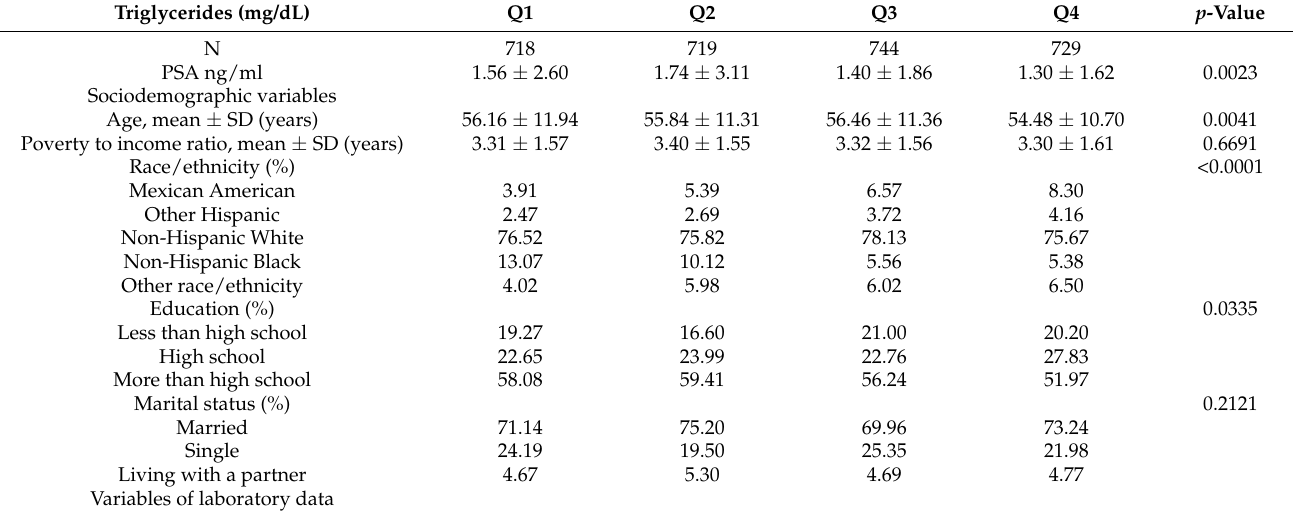
Table 1. Baseline characteristics of the selected